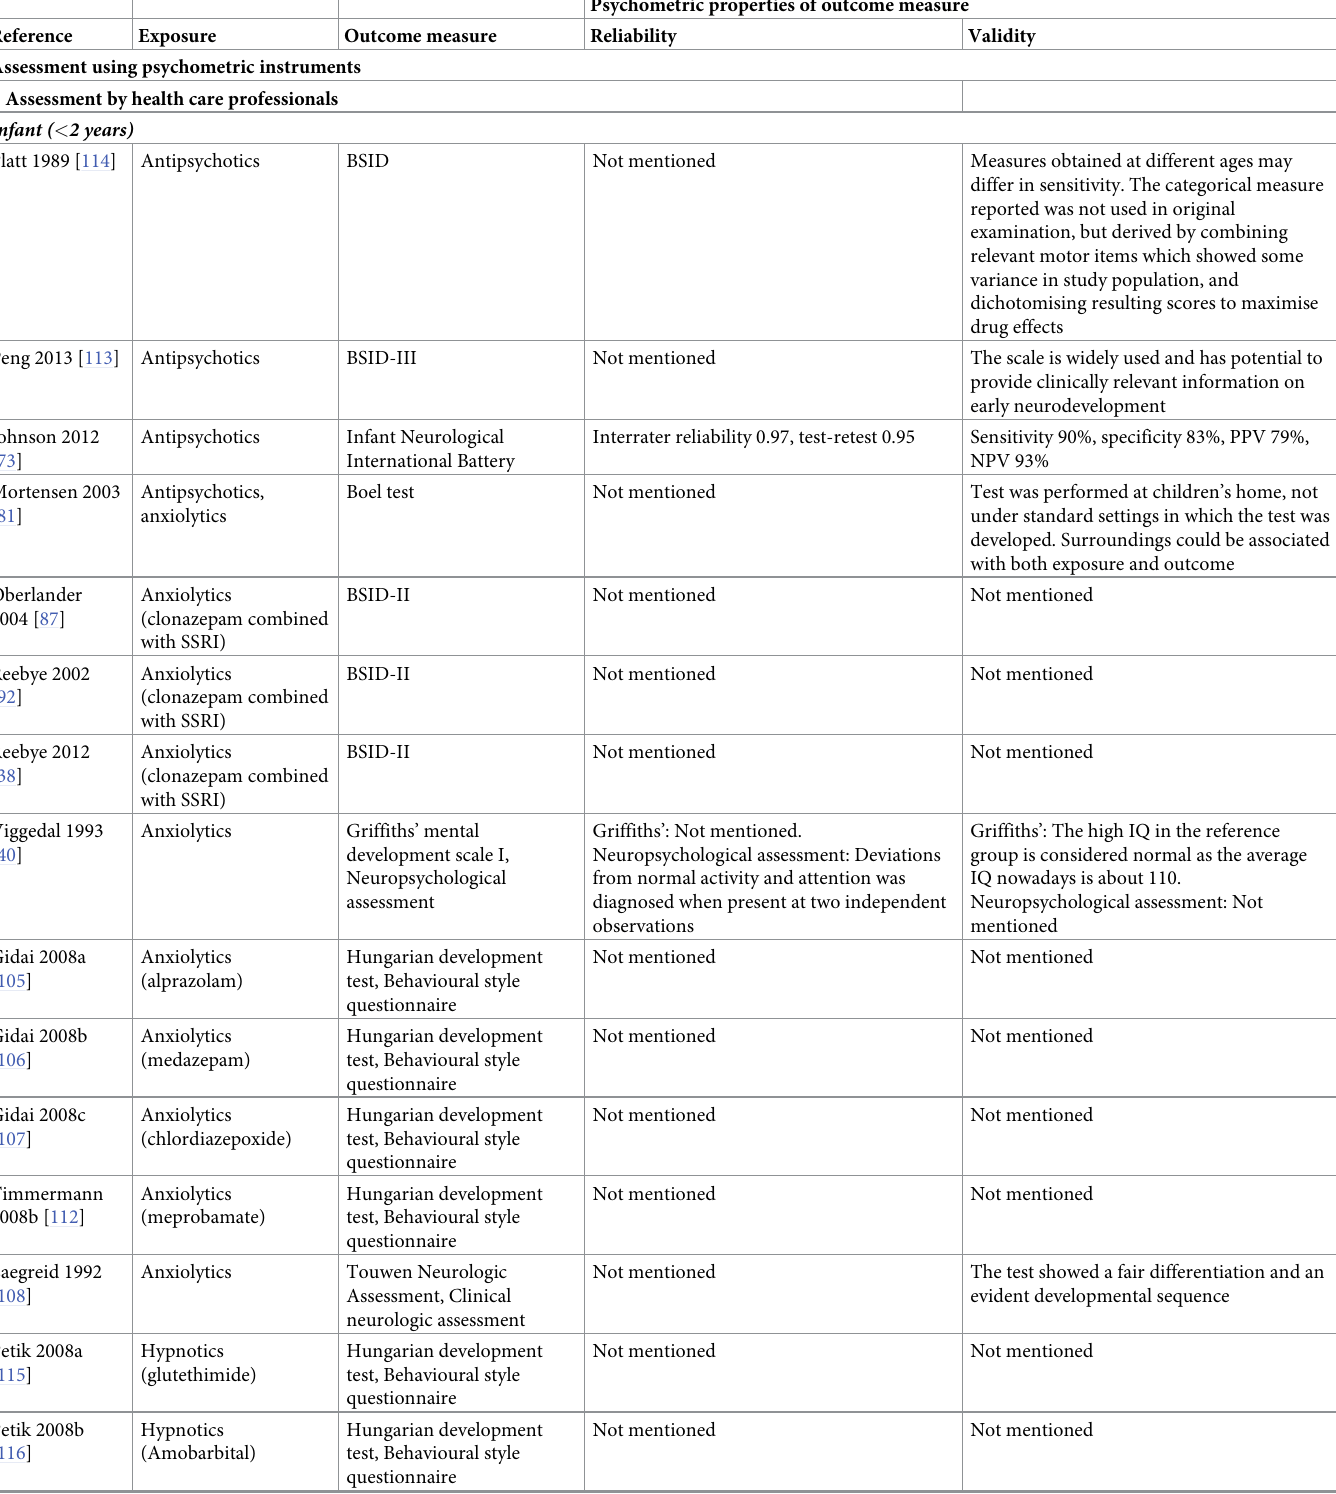
Table 2. Validity and reliability of outcome measures as reported by the authors of the study, papers on psychotropics except antidepressants. Psychometric properties of outcome